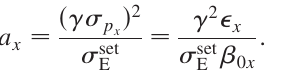
FIG. 7. (Color) Comparison of the fitted and set values of the energy spread with large emittance values, (cid:3) Other simulation parameters are found in Table I with N The inset shows the relative difference between the fitted and set values, (cid:1) diff E [Eq.